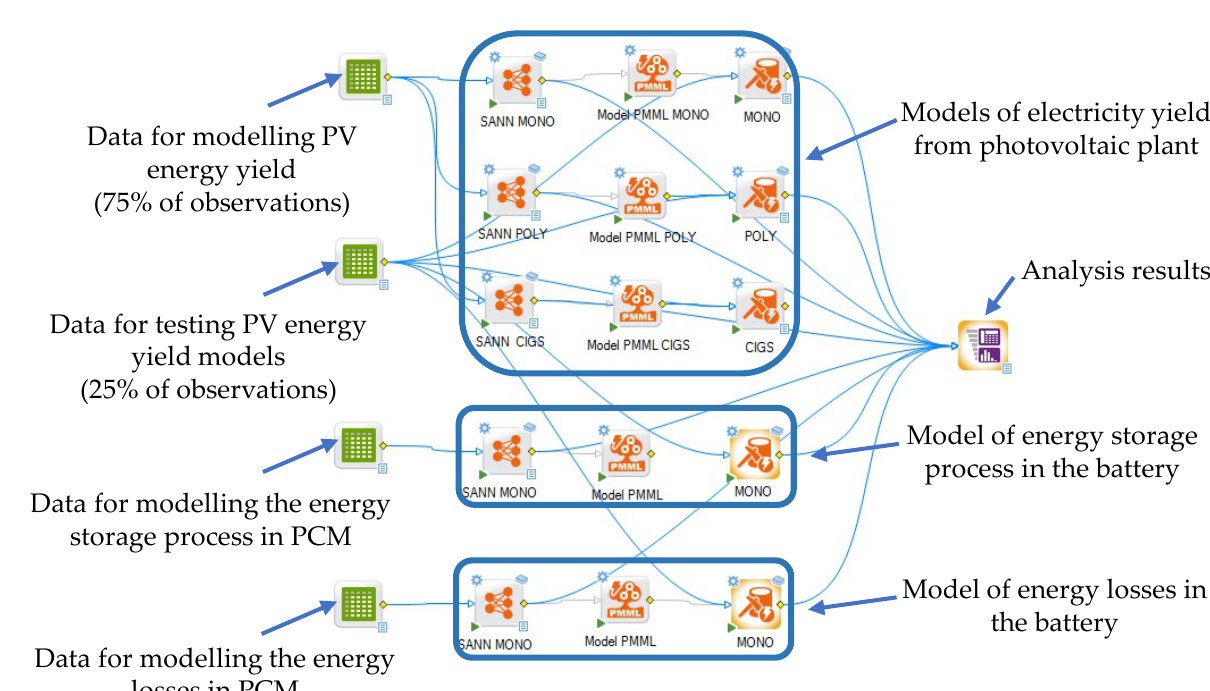
Figure 8. Models of energy storage from photoelectric conversion in the form of internal energy of the deposit in the Data Miner workspace.